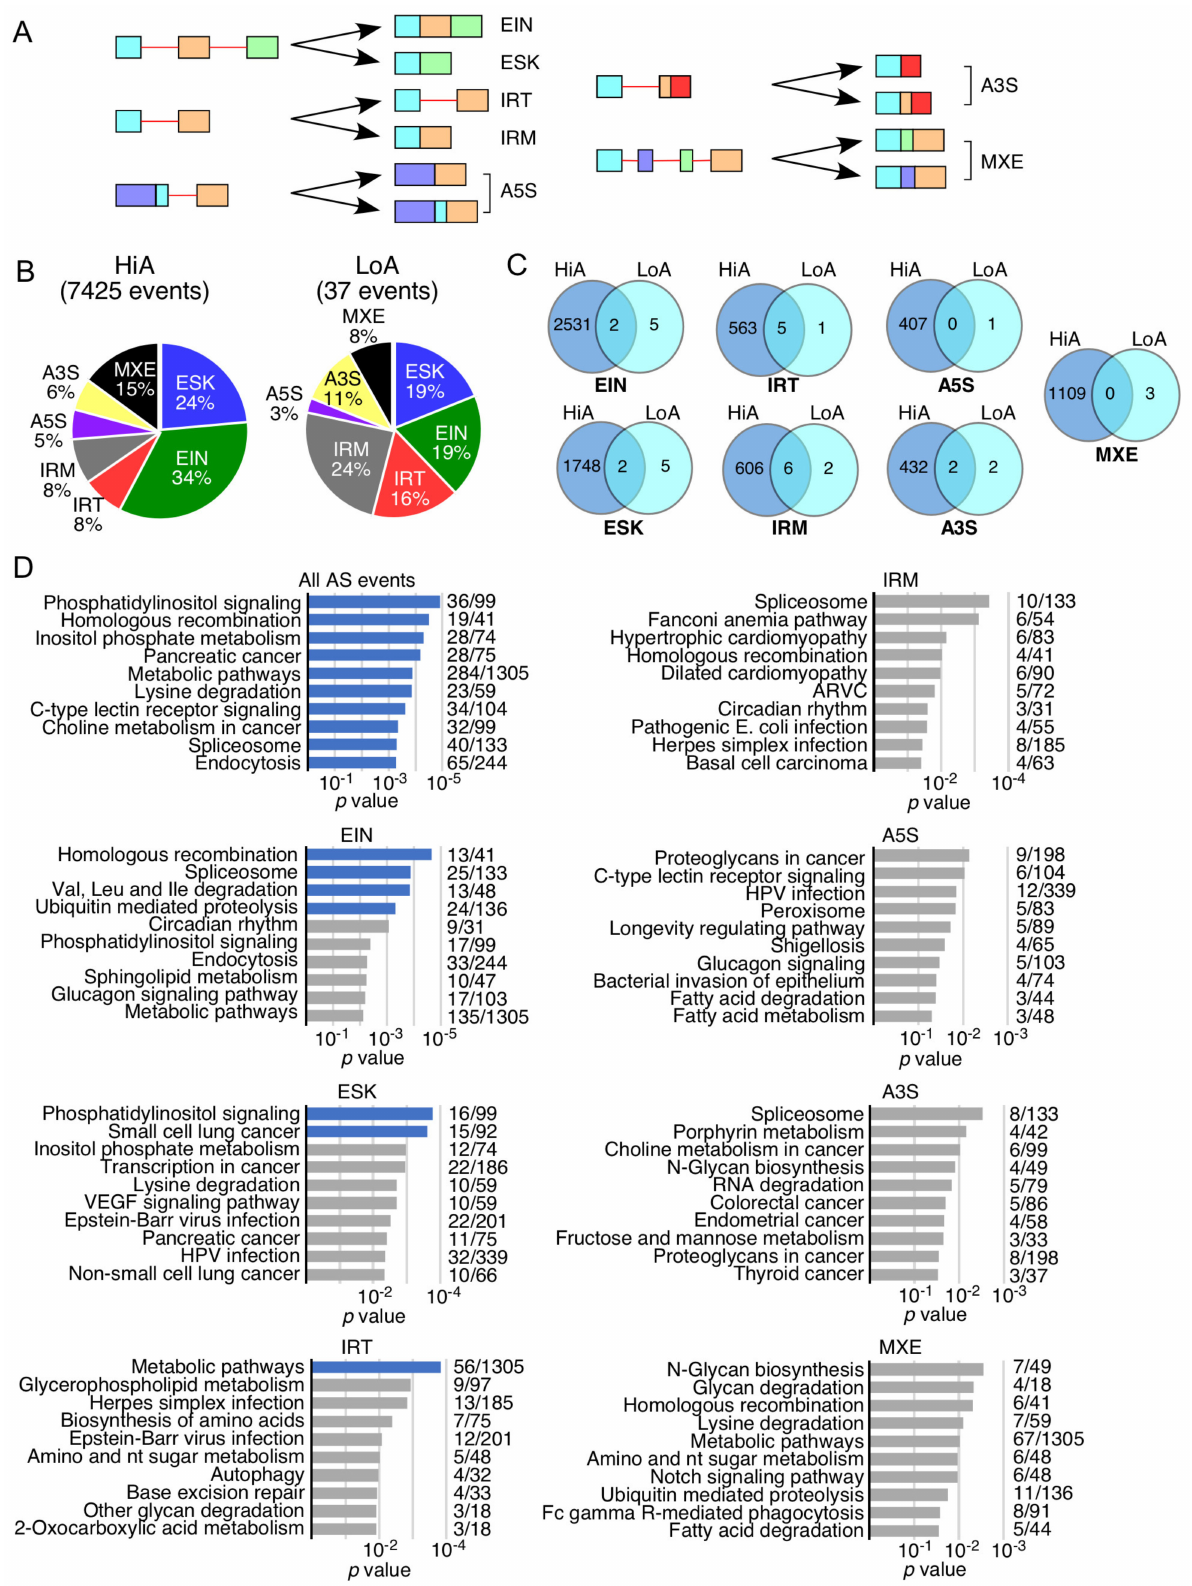
Figure 2. An overview of alternative splicing affected by Anti-N1 treatment. ( A ). Diagrammatic representation of each type of alternative splicing event under investigation. Exons are represented by colored boxes, while introns by red lines. Abbreviations: EIN, exon inclusion; ESK, exon skipping; IRT, increased intron retention; IRM, improved intron removal; A5S, alternative 5 (cid:48) splice site; A3S, alternative 3 (cid:48) splice site; MXE, mutually exclusive/mixed exons. ( B ). Pie charts